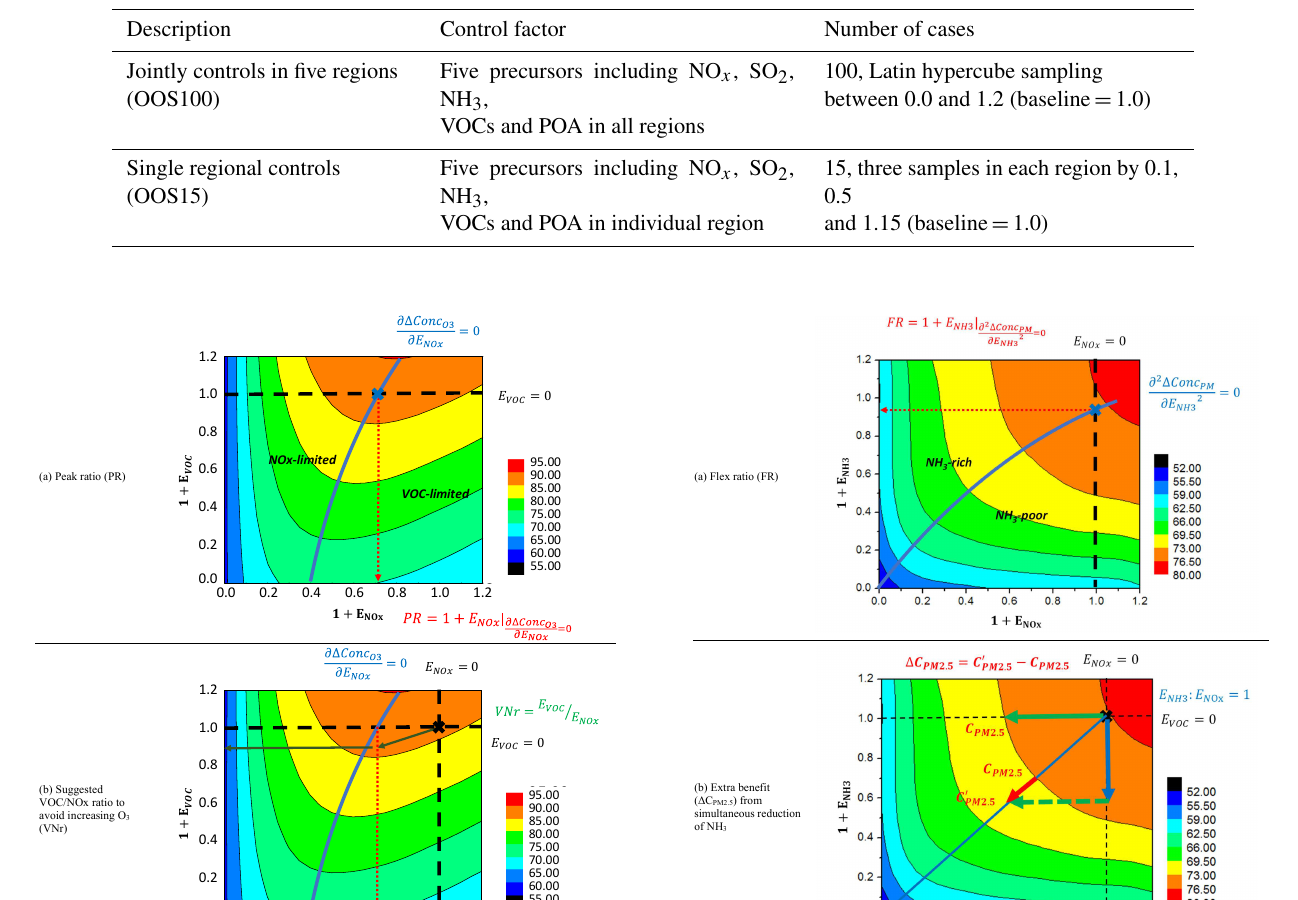
Table 2. Out-of-sample dataset for validation. Description Control factor Number of cases Jointly controls in five regions (OOS100)